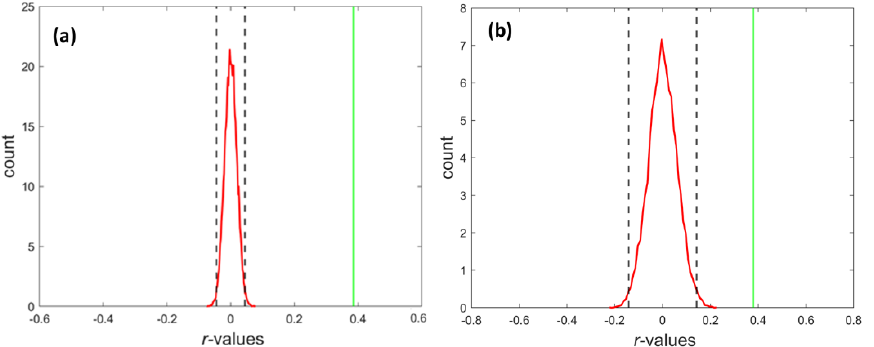
Figure A4. Permutation test analysis (randomization test). ( a ): The functional connectivity vs. structural association between neurons Y (neuron–neuron). The curve shows the distribution of r-values calculated between Y (neuron–neuron) and randomly permuted FC 20,000 times. ( b ): The BOLD signal coherence vs. the Neuronal Density Index (NDI). The curve shows the distribution of r-values calculated between NDI and randomly permuted 10,000 times BOLD signal coherence. In both plots, the 99% percentiles of the distribution lines are marked by black dashed lines, while the r-values without permutation are marked as green lines and are well outside the black lines. The result shown in the figures validates a significant difference in both cases with p -values <0.000001.